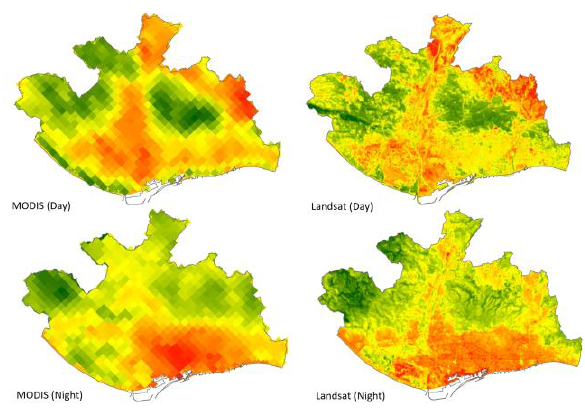
Figure 4. MODIS vs. Landsat LST (day and